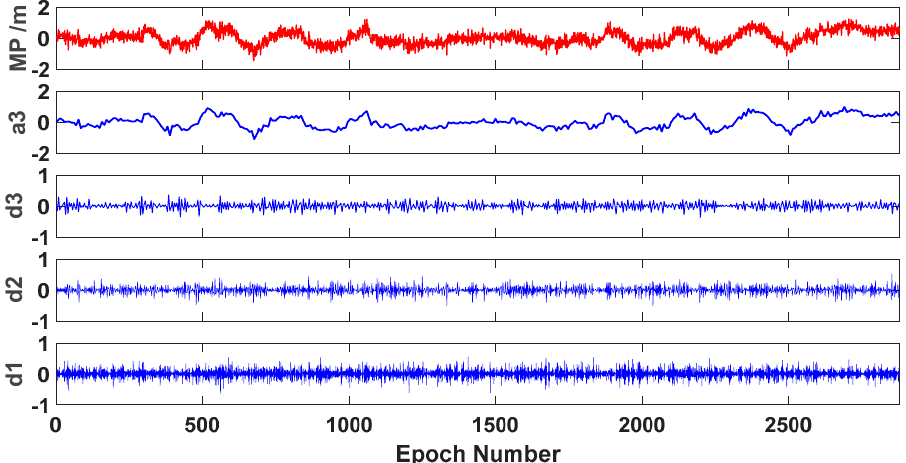
Figure 4. Wavelet decomposition and reconstruction of MP2 at CUT0 station (C04); MP represents the original multipath series; a3 represents the low frequency component of the third level; d1–d3 represent the details.